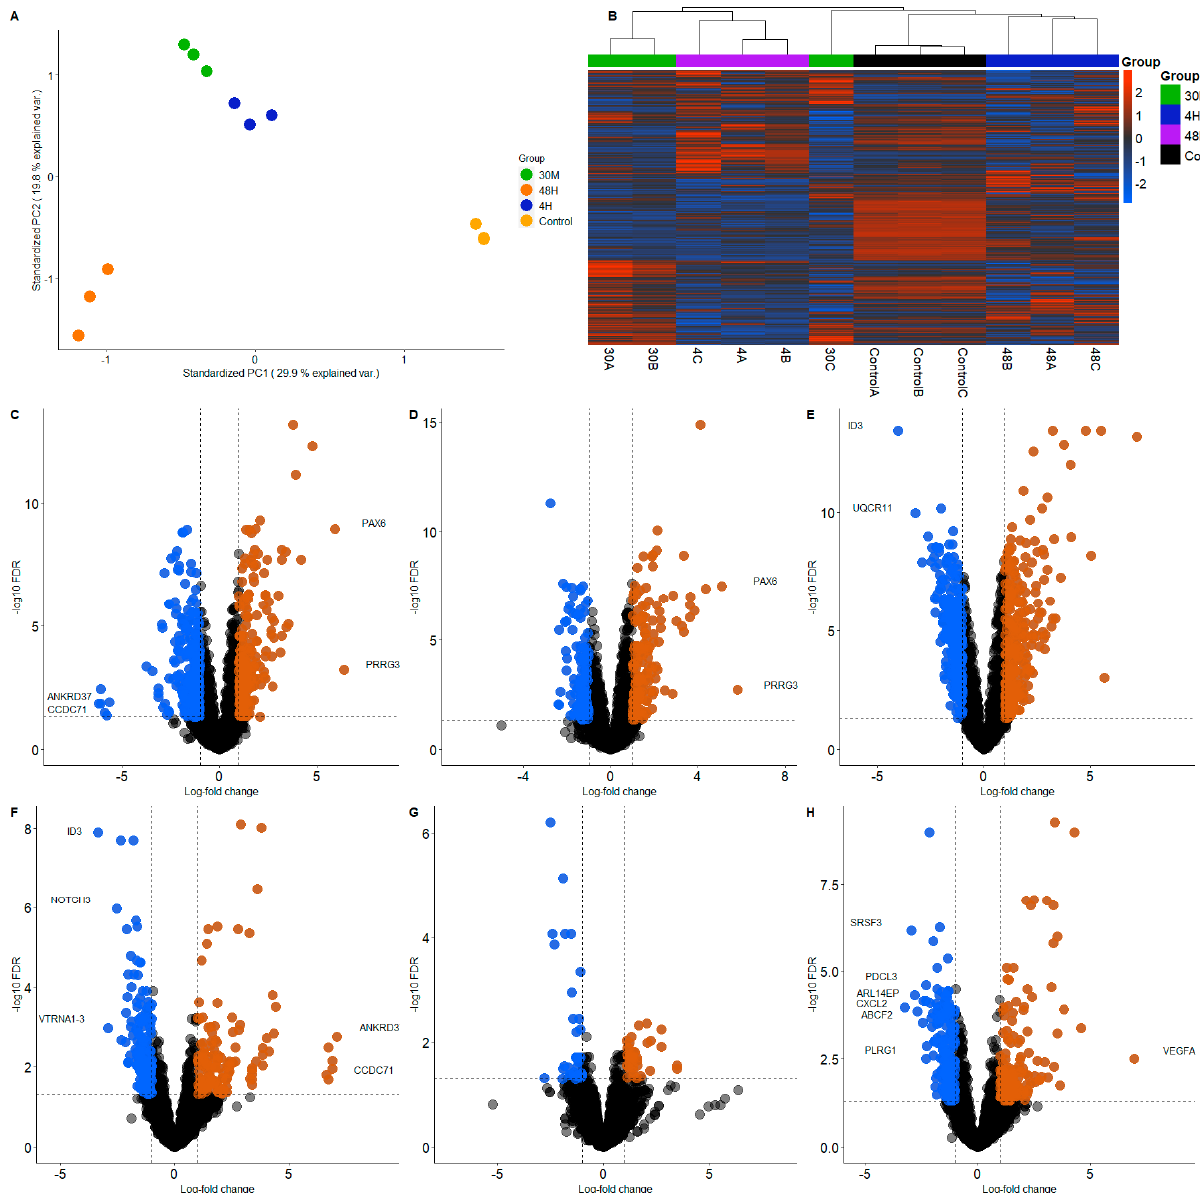
Figure 1. Receptive endometrial analogue RL95-2 cells were treated with trophoblast analogue Jar cell-derived EVs for 30 min, 4 h and 48 h to investigate the effect of trophoblastic EVs on endometrial transcriptome. ( A ) The PCA plot shows the variance between the groups (30 min; green, 4 h; blue, 48 h; orange and control; yellow). ( B ) Heatmap shows the differential expression of the genes (30 min; green, 4 h; blue, 48 h; purple and control; black). Volcano plots show the expression of individual genes in each comparison: 30 min treatment vs. control ( C ), 4 h treatment vs. control ( D ), 48 h treatment vs. control ( E ) 4 h vs. 30 min ( F ), 48 h vs. 30 min ( G ), 4 h vs. 48 h ( H ). Downregulation (FDR < 0.05, logFC < − 1) is denoted in blue and upregulation (FDR < 0.05, logFC > 1) in orange.